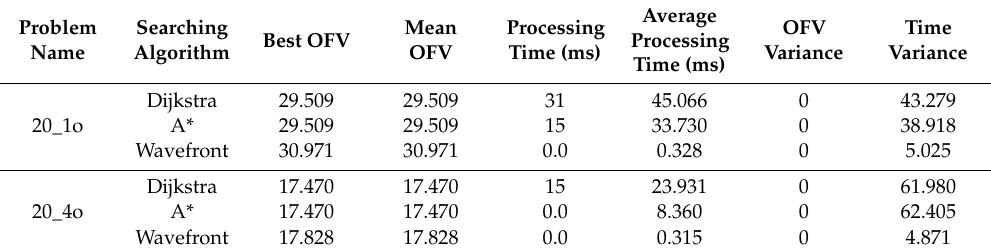
Table 13. Experimental results of the other algorithms within 20 × 20 case.